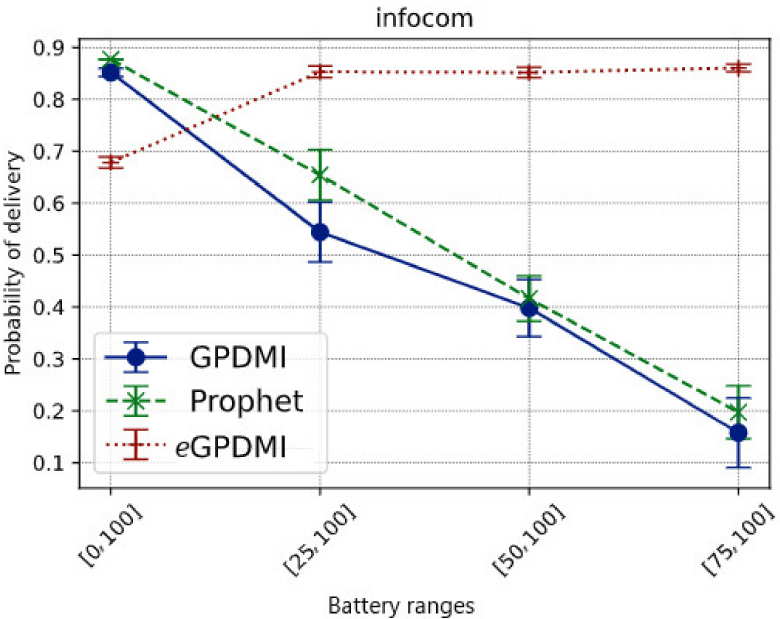
Figure 3. Impact of battery ranges on the delivery probability of messages in the Infocom mobil- ity